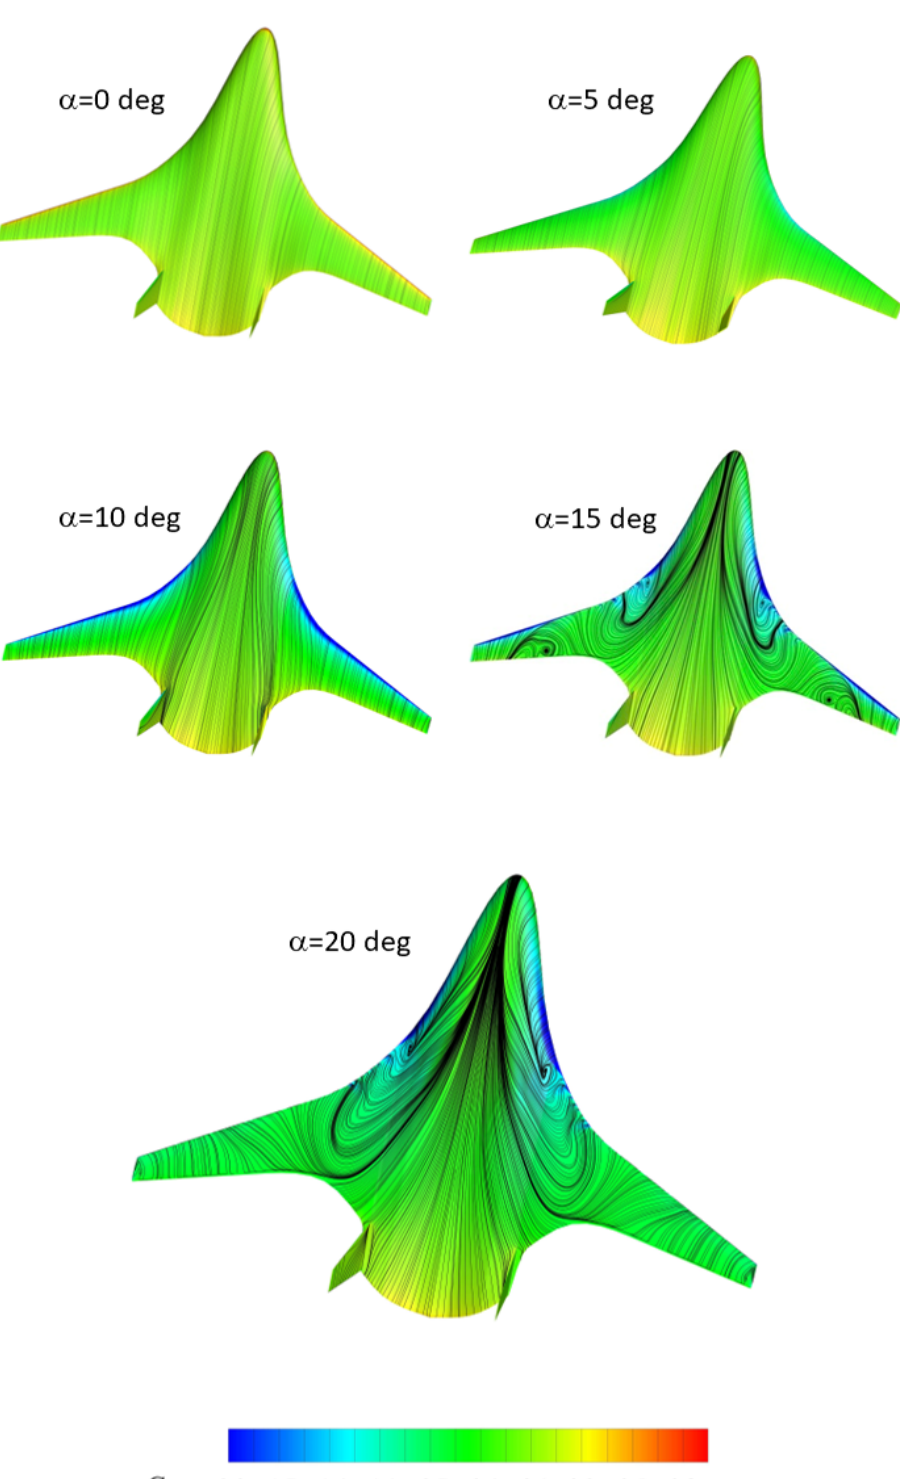
Figure 10. Shearlines and pressure coefficient (Cp) distribution at different AoAs, namely 0 ◦ , 5 ◦ , 10 ◦ , 15 ◦ , and 20 ◦